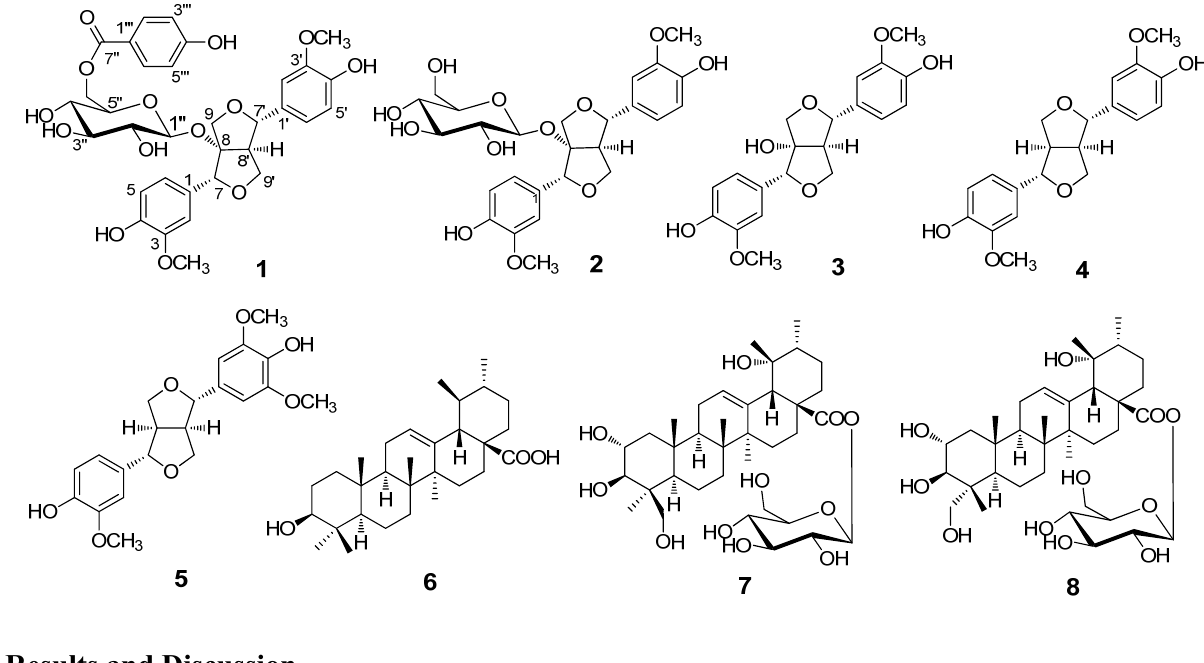
Figure 1. Chemical structures of compounds 1 – 8 from the whole plants of Salvia scapiformis